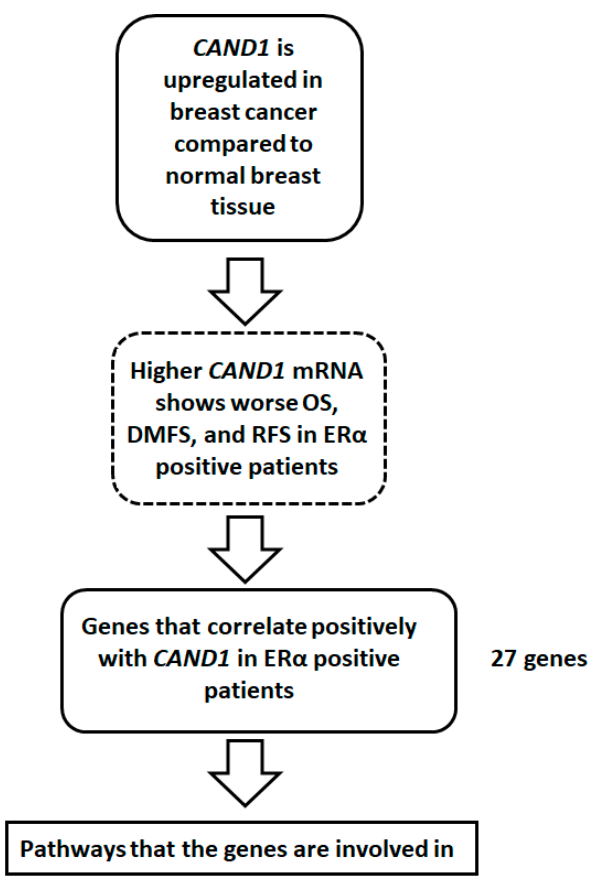
Figure 5. Schematic presentation of the experimental design followed in this study.